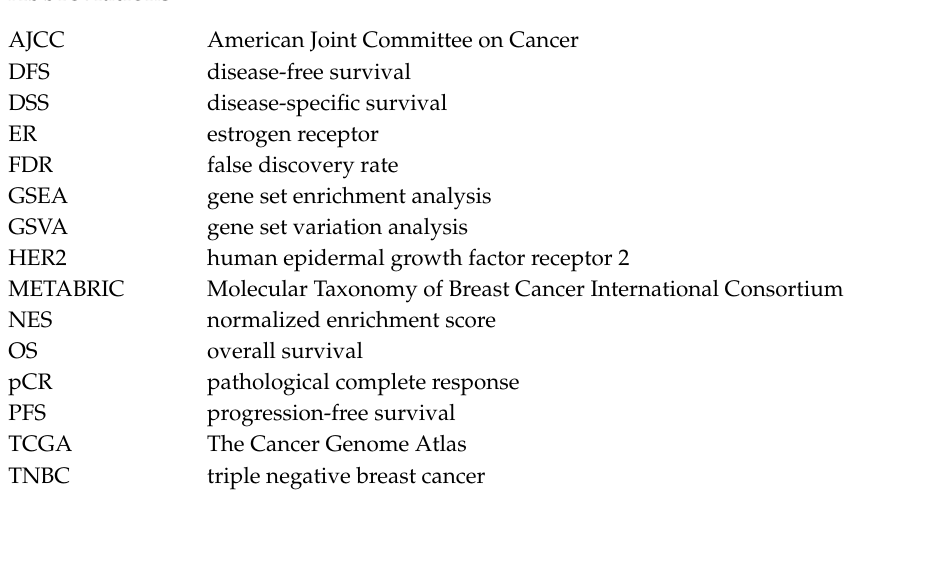
Figure S1: Association of conventional dendritic cells (cDCs) and plasmacytoid dendritic cells (pDCs) with clinical features in the METABRIC cohort, Figure S2: Association between cDCs or pDCs and survival of estrogen receptor (ER)-positive / human epidermal receptor 2 (HER2)-negative patients, Figure S3: Correlation analysis of cDCs or pDCs in ER-positive / HER2-negative with CD8 + T cells, CD4 + memory T cells, IFN- γ pathway, and cytolytic activity score (CYT), Table S1: Marker genes used to define conventional dendritic cells (cDCs) and plasmacytoid dendritic cells (pDCs) by